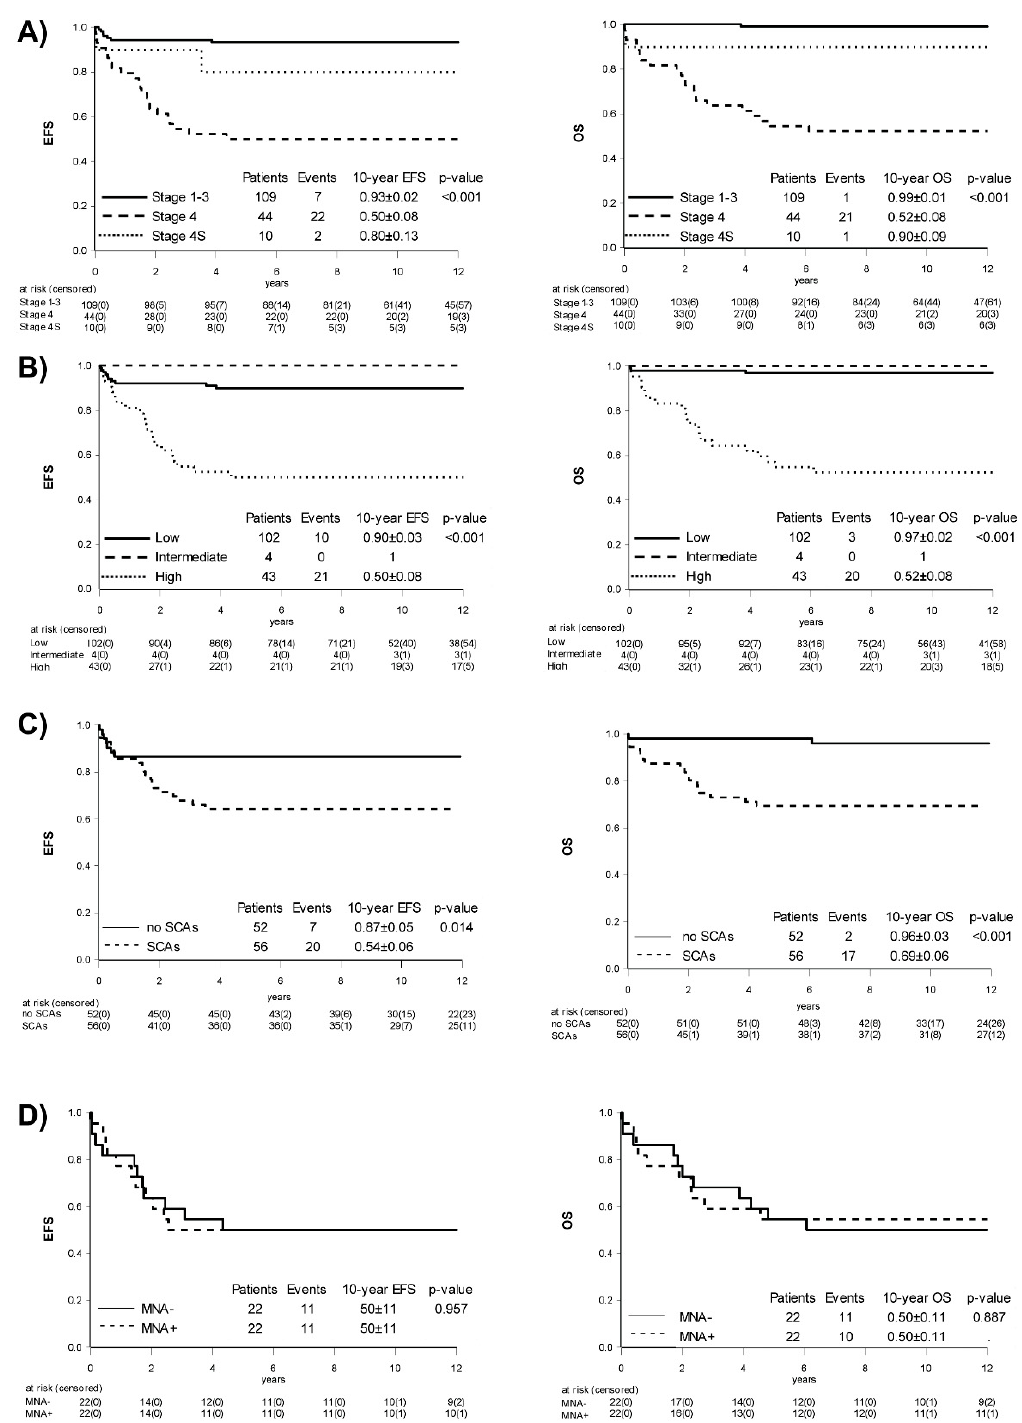
Figure 1. EFS and OS by ( A ) prospective International Neuroblastoma Staging System (INSS) as outlined in the A-NB94 trial; ( B ) post hoc grouping according to the International Neuroblastoma Risk Group (INRG) Staging System; ( C ) presence or absence of segmental chromosomal aberrations (SCAs); ( D ) effect of MYCN amplification (MNA) status in INSS stage 4 patients